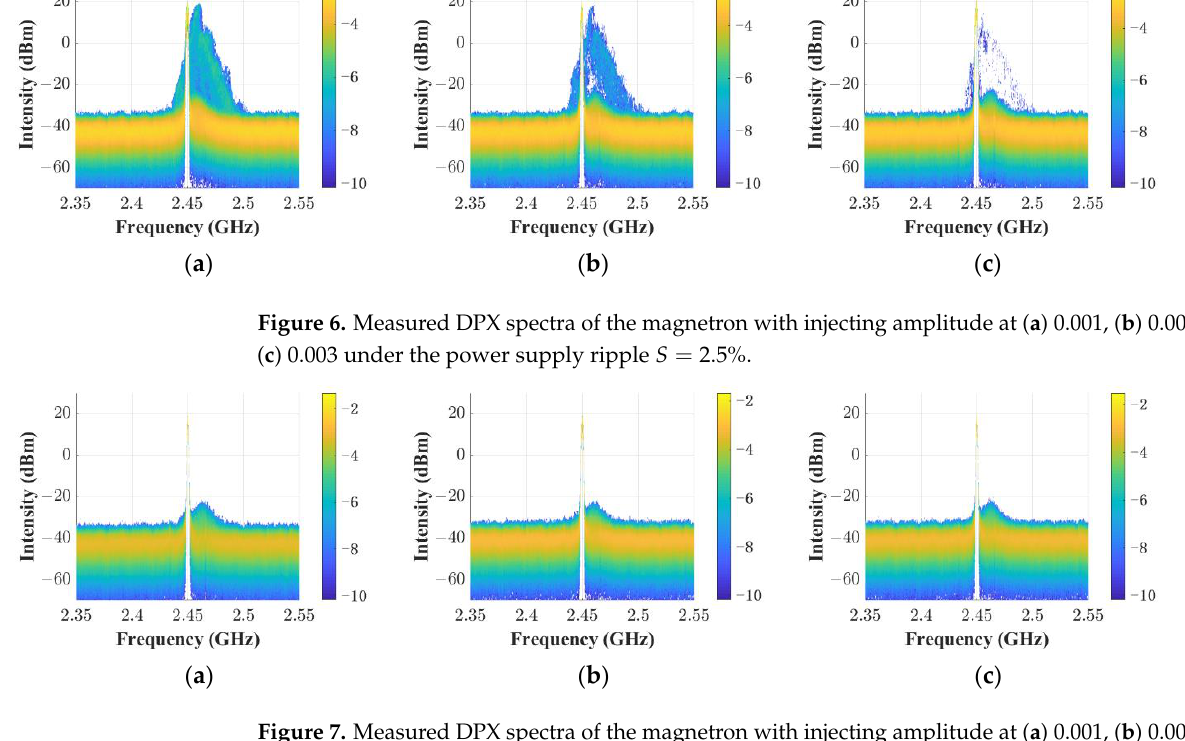
Figure 6. Measured DPX spectra of the magnetron with injecting amplitude at ( a ) 0.001, ( b ) 0.002 and ( c ) 0.003 under the power supply ripple 𝑆 = 2.5% .